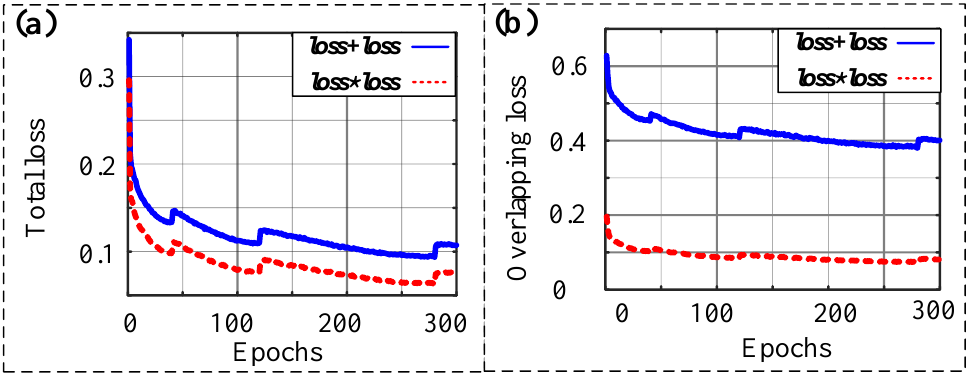
Figure 6. Comparison of loss function decline in the case of 10 epochs: ( a ) total loss; ( b ) overlapping loss.